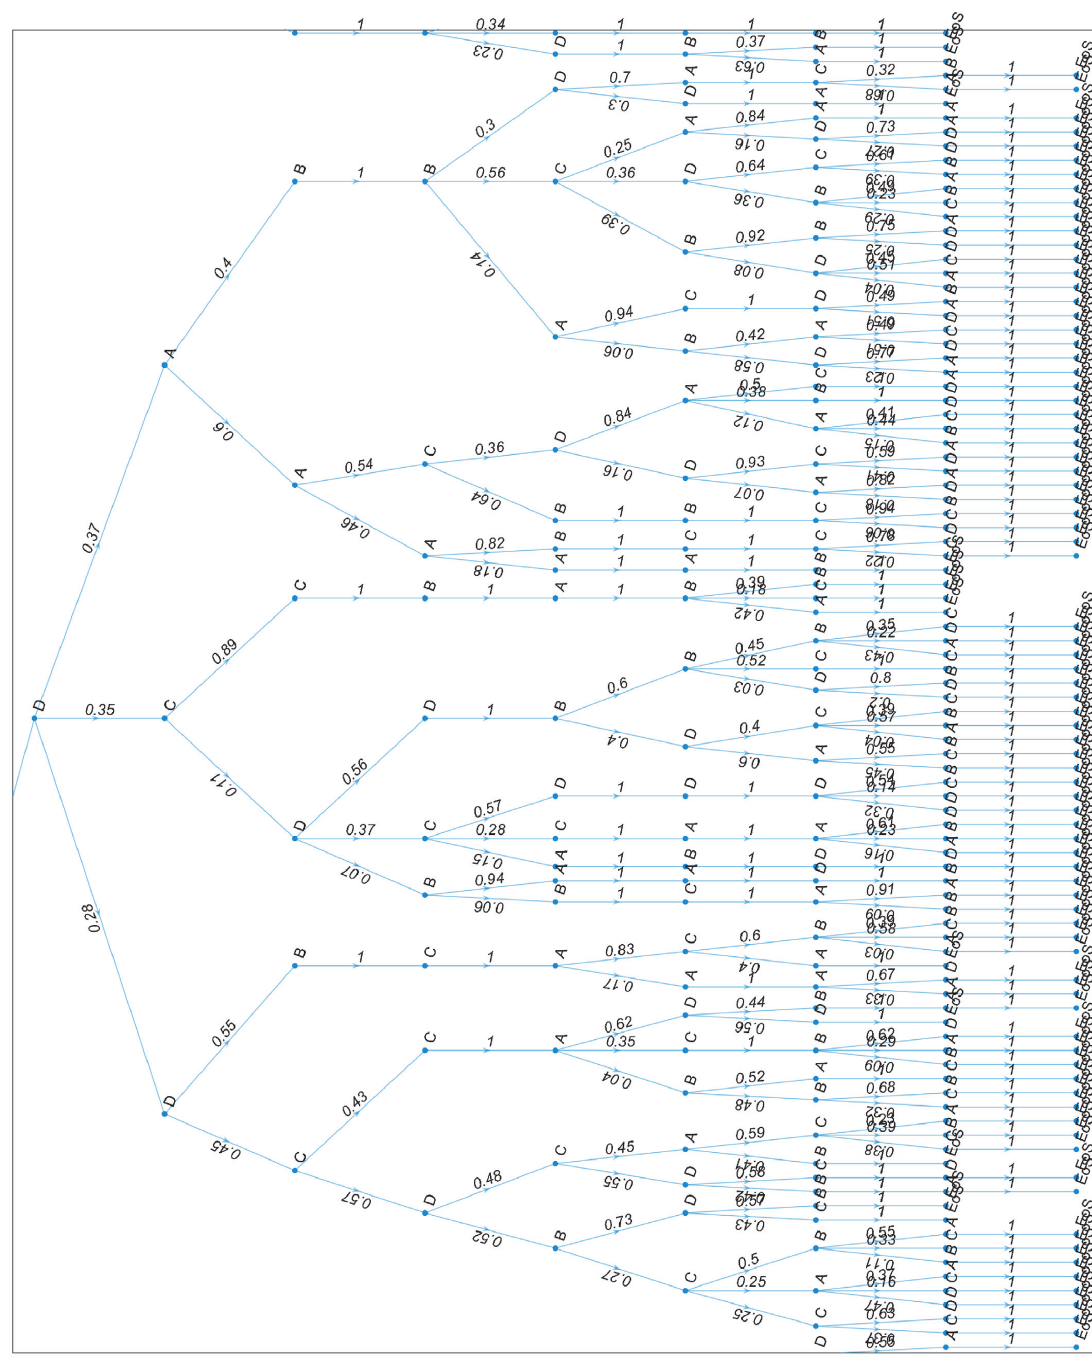
Figure 10: The state transition probabilities of the full tree-based system, assuming [D D] event